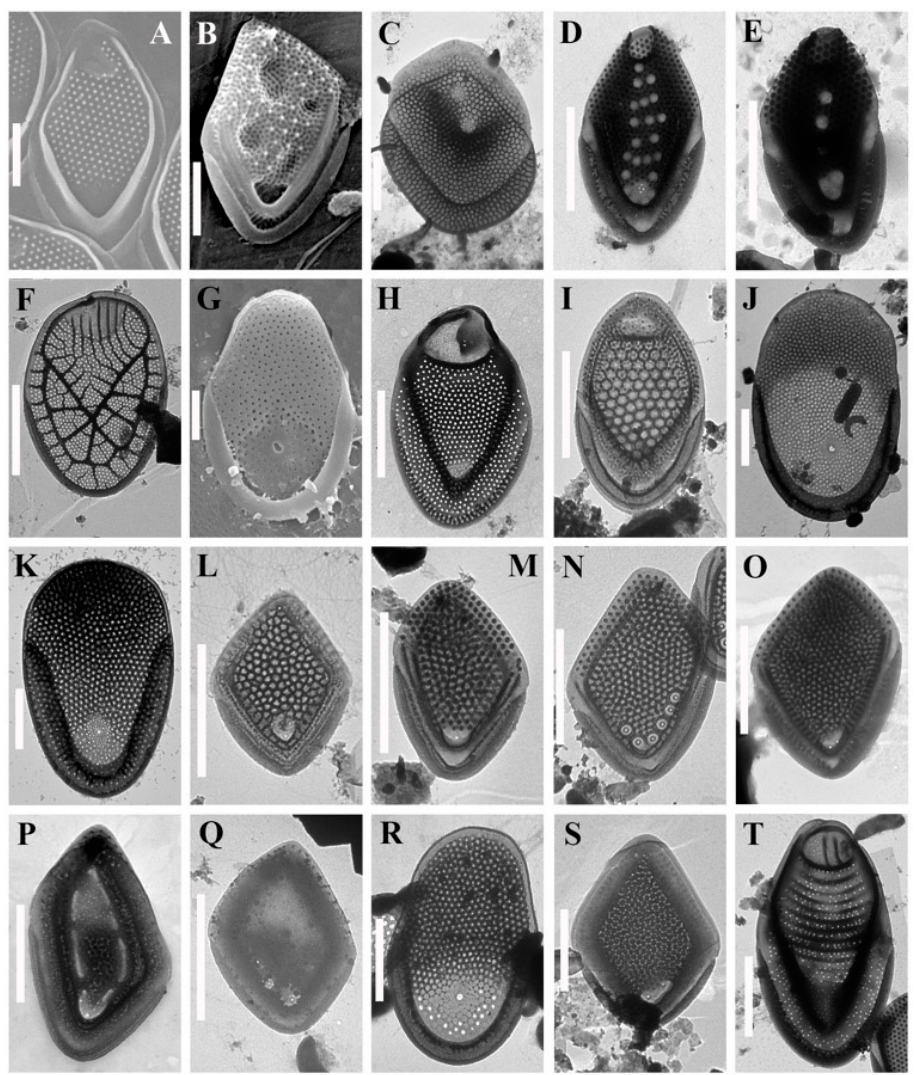
Figure 3. Scales of Mallomonas . ( A ) M. furtiva . ( B ) M. grata . ( C ) M. gusakovii . ( D ) M. guttata var. guttata . ( E ) M. guttata var. simplex . ( F ) M. harrisiae . ( G ) M. hexareticulata . ( H ) M. kenyana . ( I ) M.